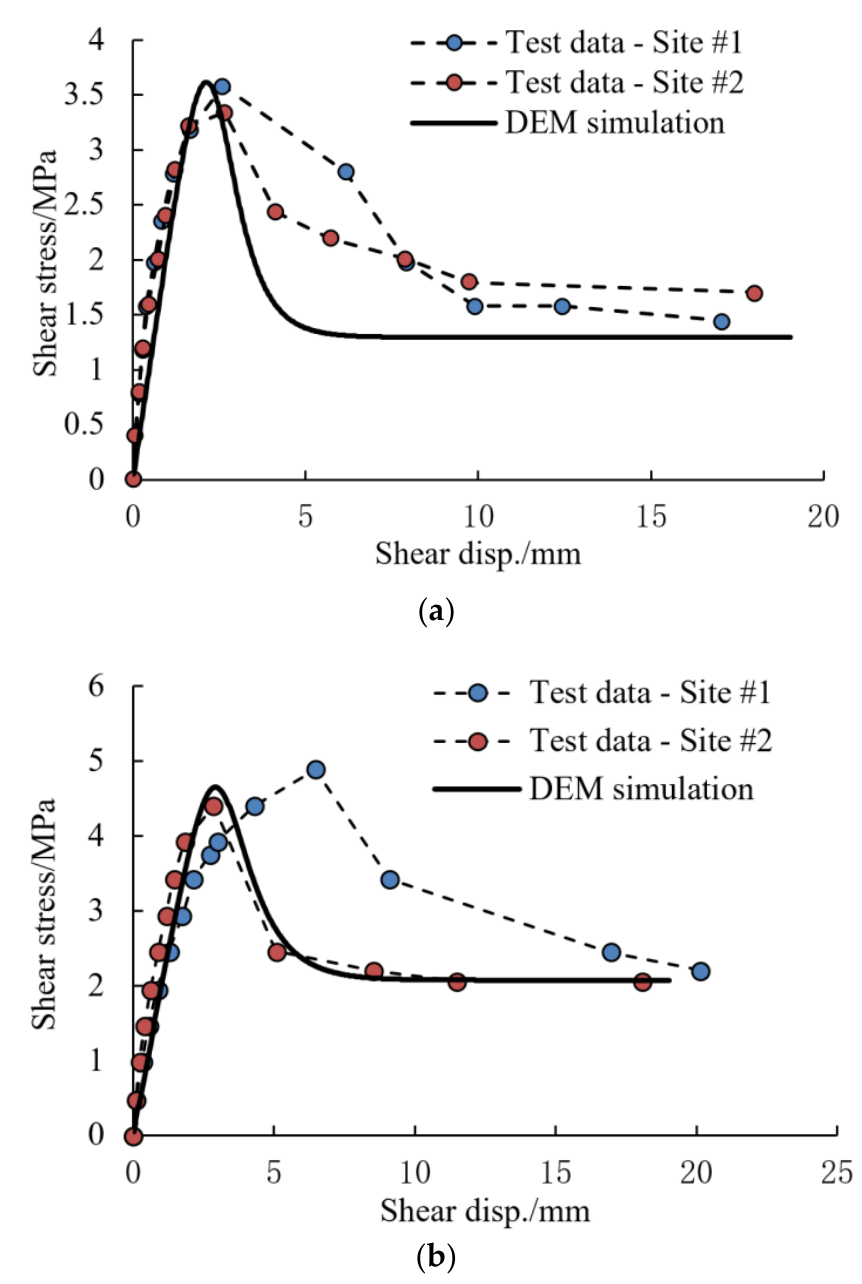
Figure 5. Comparison of the test data with DEM simulation. ( a ) Normal stress = 1.25 MPa, ( b ) Normal stress = 2.0 MPa.